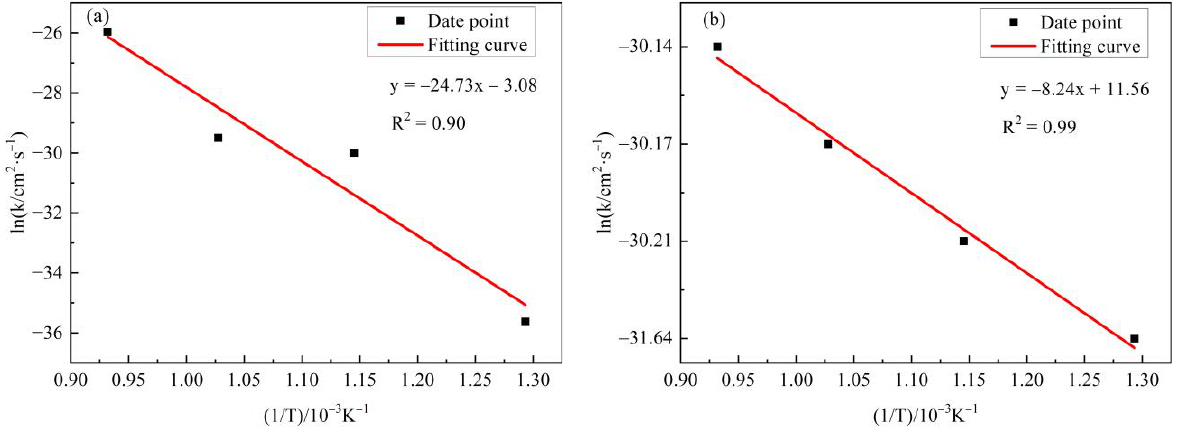
Figure 8. The relationship between lnk of N and O and 1/T ( a ) N element; ( b ) O Element.